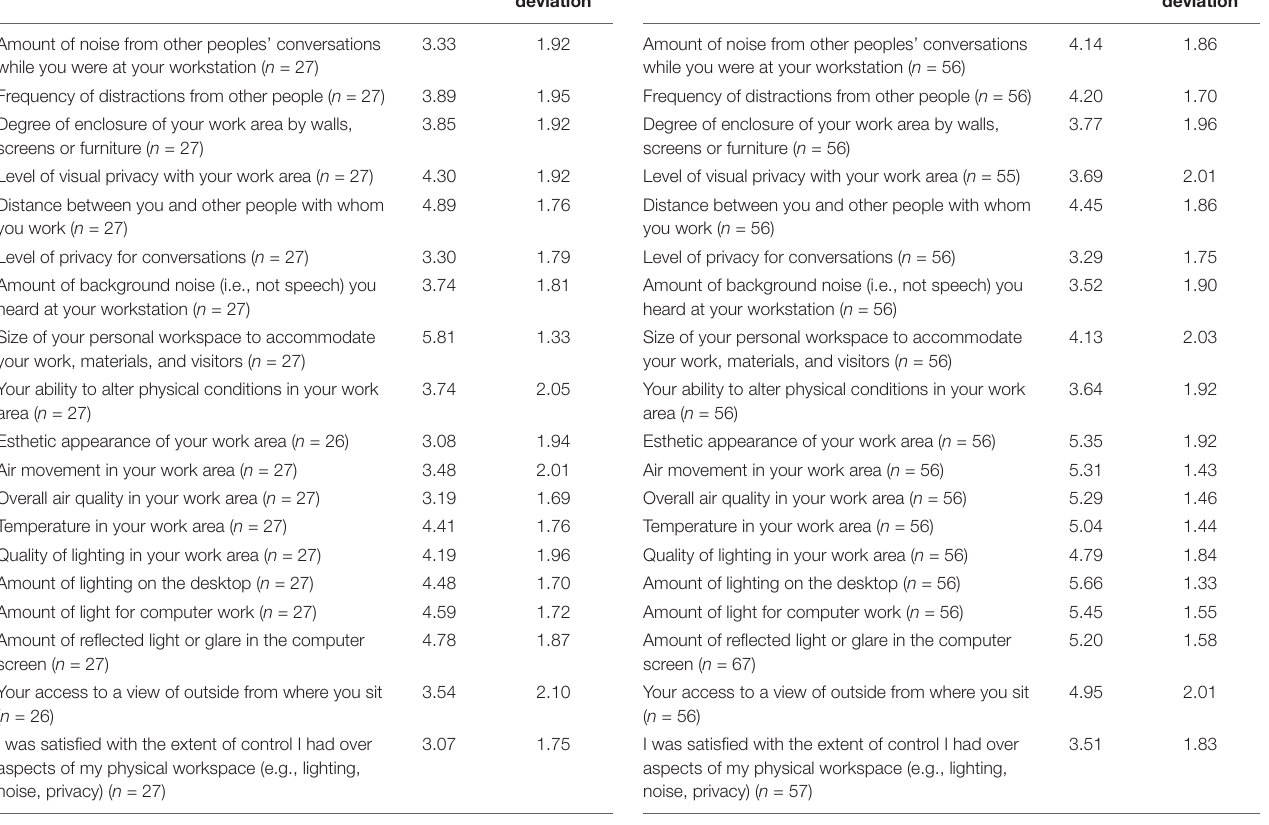
TABLE 4 | Descriptive statistics for items measuring occupant satisfaction with their environment at work after renovation (Time 2). Item